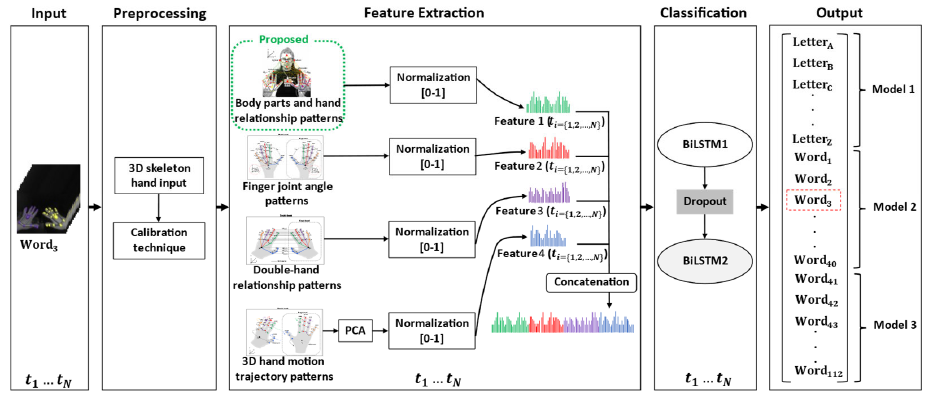
Figure 8. Proposed method.